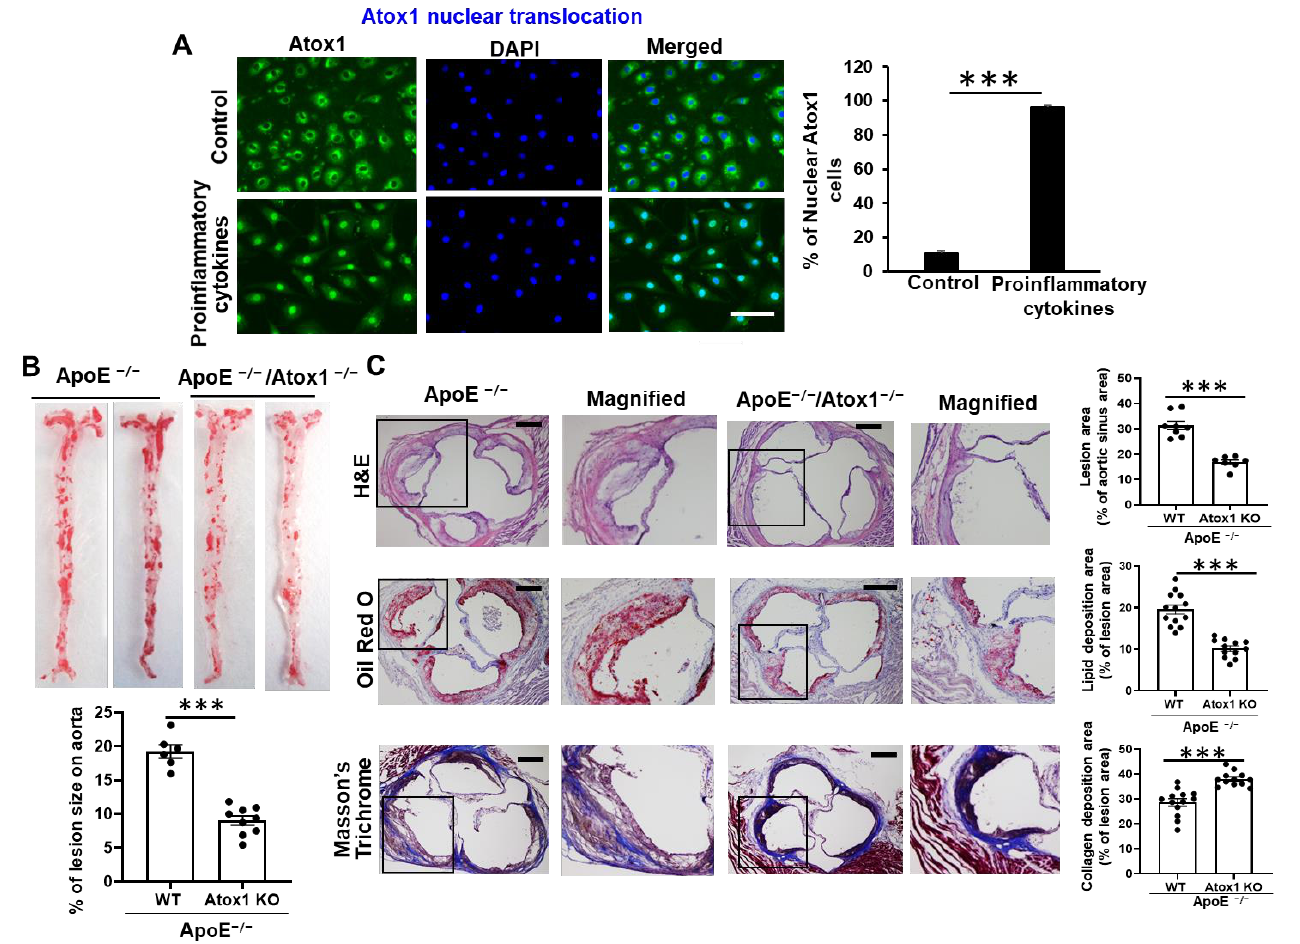
Figure 1. Role of Atox1 in inflammatory disease. ( A ). Immunofluorescence staining of Atox1. HUVECs stimulated with proinflammatory cytokine cocktail (TNF- α (10 ng/mL), IL- 1β (10 ng/mL), and IL-6 (10 ng/mL) for 1 h were immunostained for Atox1 using anti-Atox1 Ab or nuclear marker DAPI. Percentage of Atox1+ cells in nucleus was shown in right (n = 3) Scale:50 μ m. ( B , C ). Loss of Atox1 decreases atherosclerotic lesion in ApoE − / − mice. ApoE − / − or Atox1 − / − /ApoE − / − were fed a Western diet for 16 weeks. ( B ). Representative images of Oil Red O stained-aortas (en face) from ApoE − / − (n = 6) or Atox1 − / − /ApoE − / − (n = 9) mice after 16 weeks of Western diet. (Lower panel) Quantification data of lesion area. ( C ). Representative images and quantification data of cross-sections of aortic sinus of ApoE − / − or Atox1 − / − /ApoE − / − mice with 16 weeks of Western diet. Sections were stained with Oil Red O (lesion), hematoxylin and eosin (plaque), and Masson’s trichrome (coll agen) with the magnified inset (black box) (n = 8 – 13 ). Scale bar: 200 μm. *** p < 0.001.